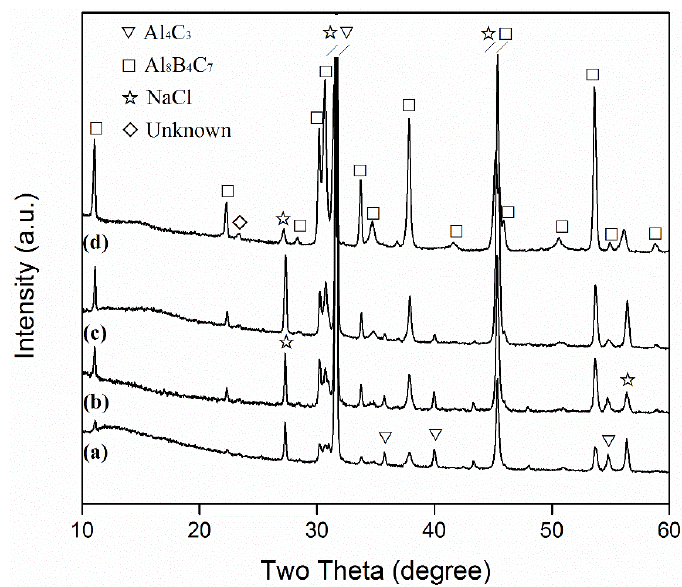
Figure 1. X-ray diffraction (XRD) patterns of samples resulting from 6 h of firing in 95%NaCl + 5%NaF salt at: ( a ) 1100, ( b ) 1150, ( c ) 1200, and ( d ) 1250 °C, respectively (prior to water washing).